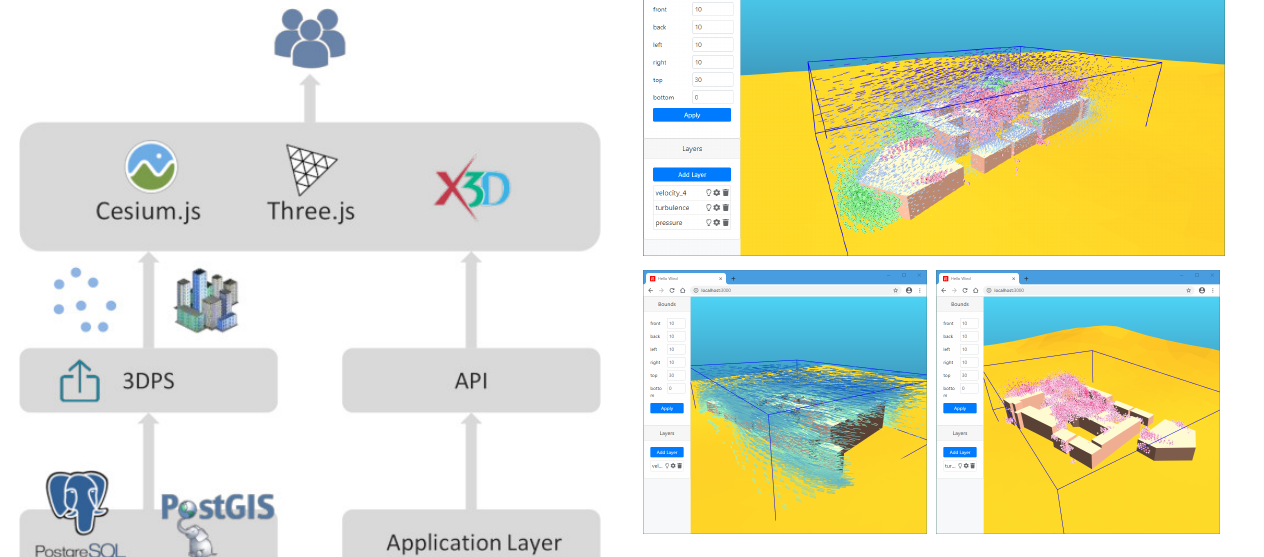
Figure 3. Overall architecture of the application